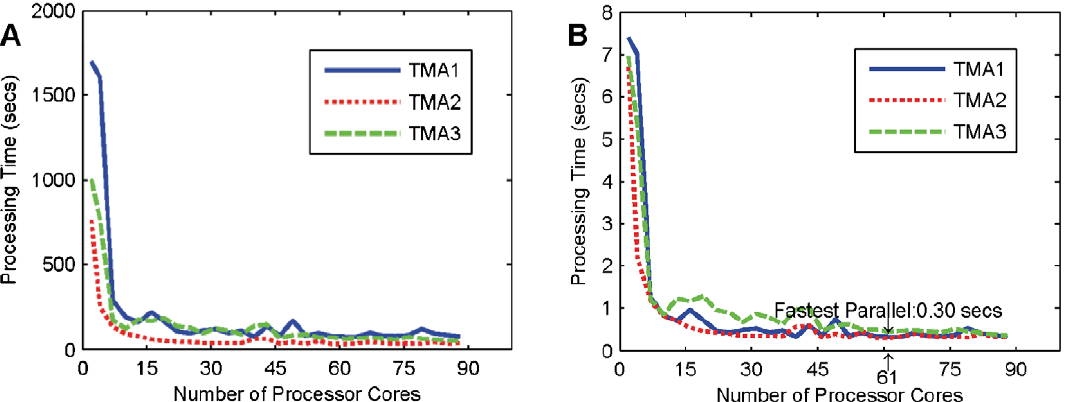
Fig. 10. Results for the amount of time for IHC quantification for all 3 TMA virtual slides. (A) Overall processing time for 3 TMA virtual slides, (B) average processing time per TMA core. (Colours are visible in the online version of the article; http://dx.doi.org/10.3233/ACP-CLO-2010- 0551.)